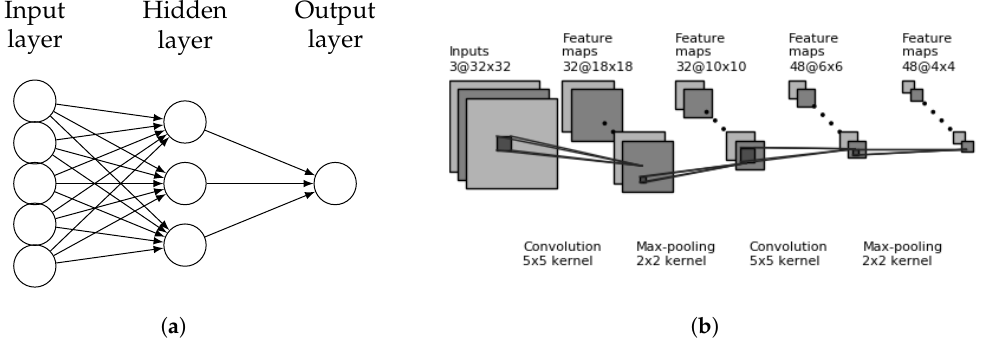
Figure 2. ( a ) Example of a fully connected neural network with one hidden layer. ( b ) Example of a CNN with two convolutional